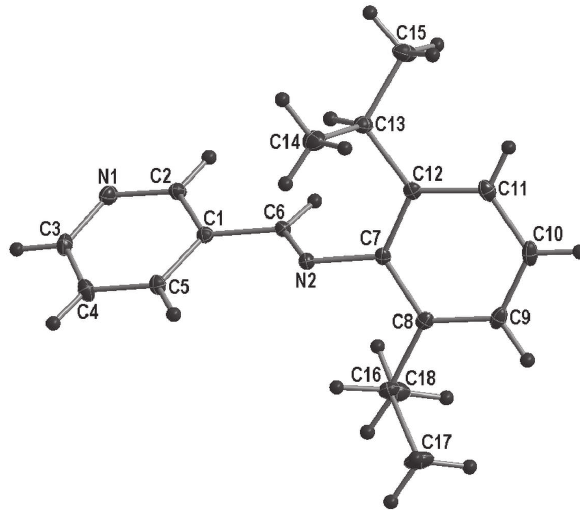
Table 1: Data collection and handling.